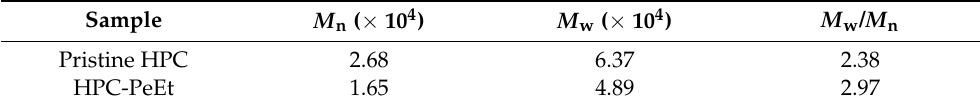
Table 1. SEC results of pristine HPC and